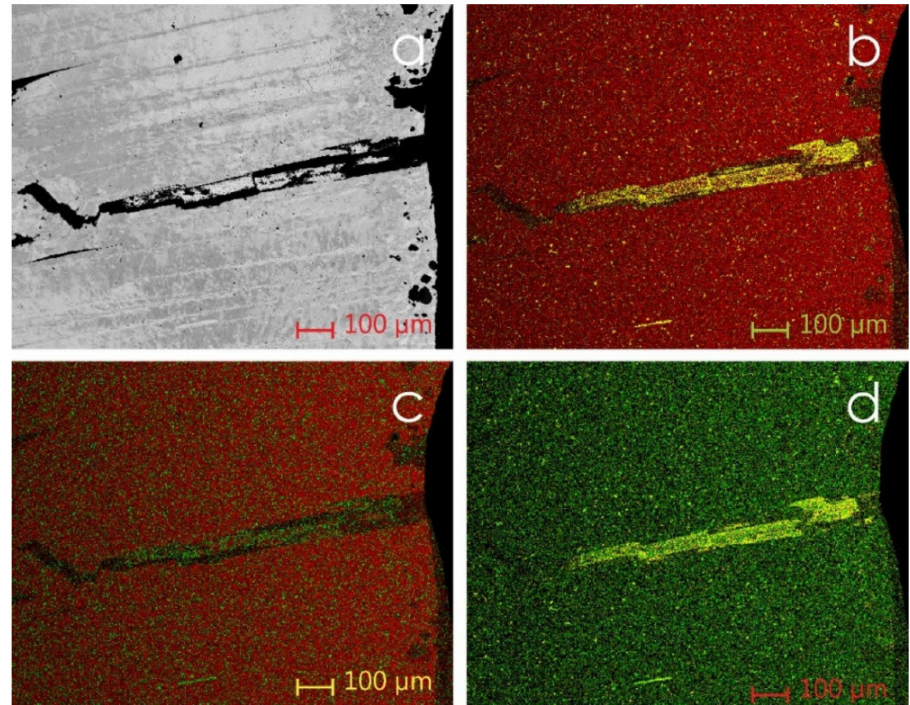
Figure 10. SEM micrograph ( a ) and associated X-ray maps ( b – d ) showing the distribution Fe, Ni and P in red, green and yellow respectively for Find 1 iron meteorite [30].